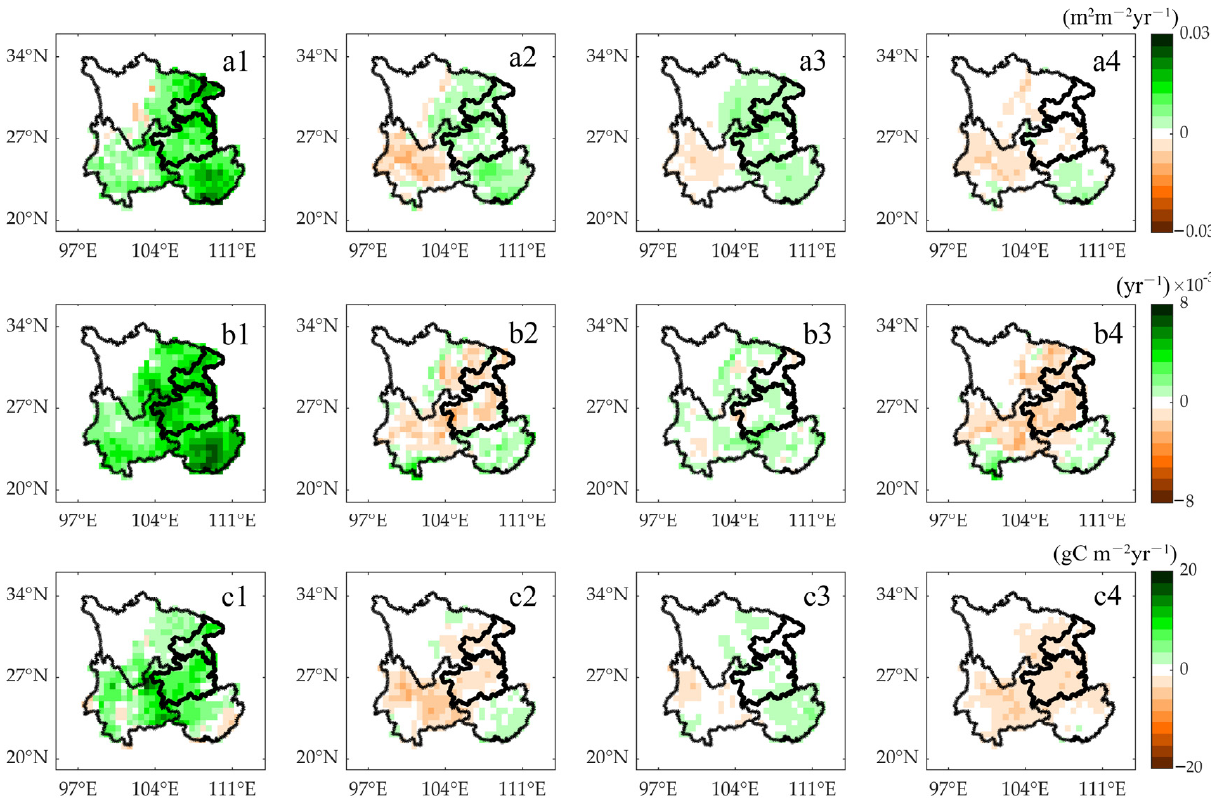
Figure 7. The spatial change trend of LAI, EVI, and GPP in SWC. ( a1 – a4 ), ( b1 – b4 ), and ( c1 – c4 ) represent the spatial change trend of LAI, EVI, and GPP, respectively; ( a1 , b1 , c1 ) are LTT, ( a2 , b2 , c2 ) are the difference between LTT and BDT; ( a3 , b3 , c3 ) are the difference between LTT and ADT, and ( a4 , b4 , c4 ) are the difference between ADT and